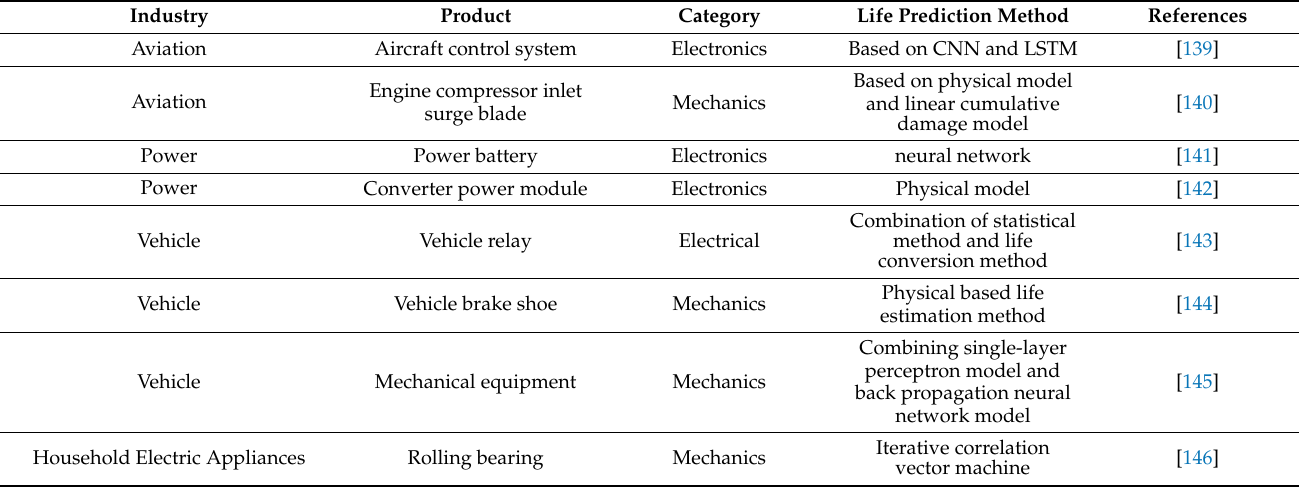
Table 10. Remaining life prediction methods in various